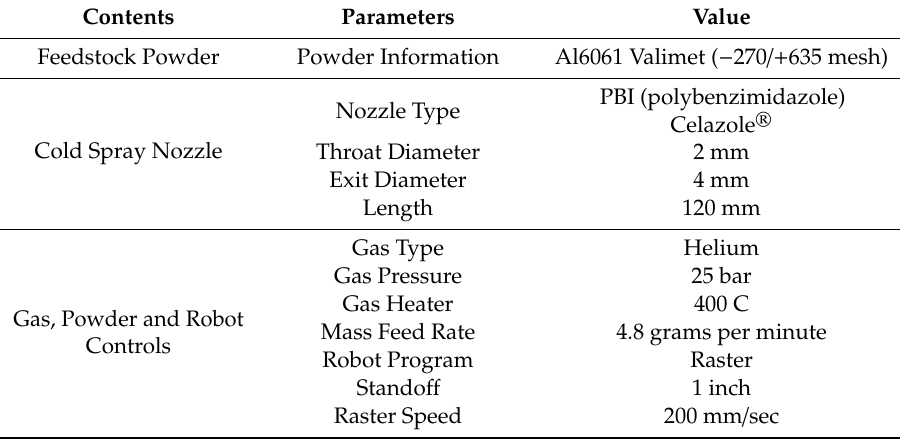
Table 1. Cold spray processing parameters for Al 6061 bulk deposit.